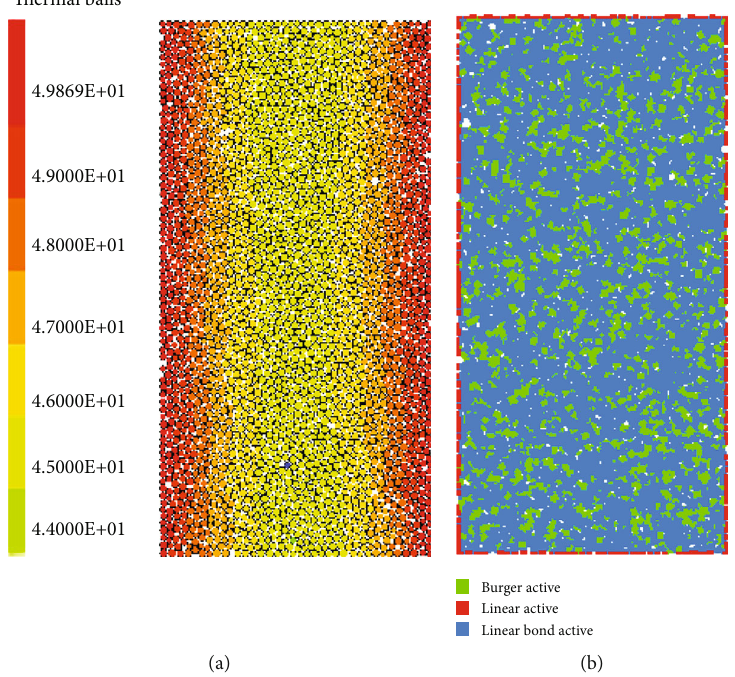
Figure 2: Numerical model of the salt rock: (a) particle model of heat transfer; (b) di ff erent contact models between